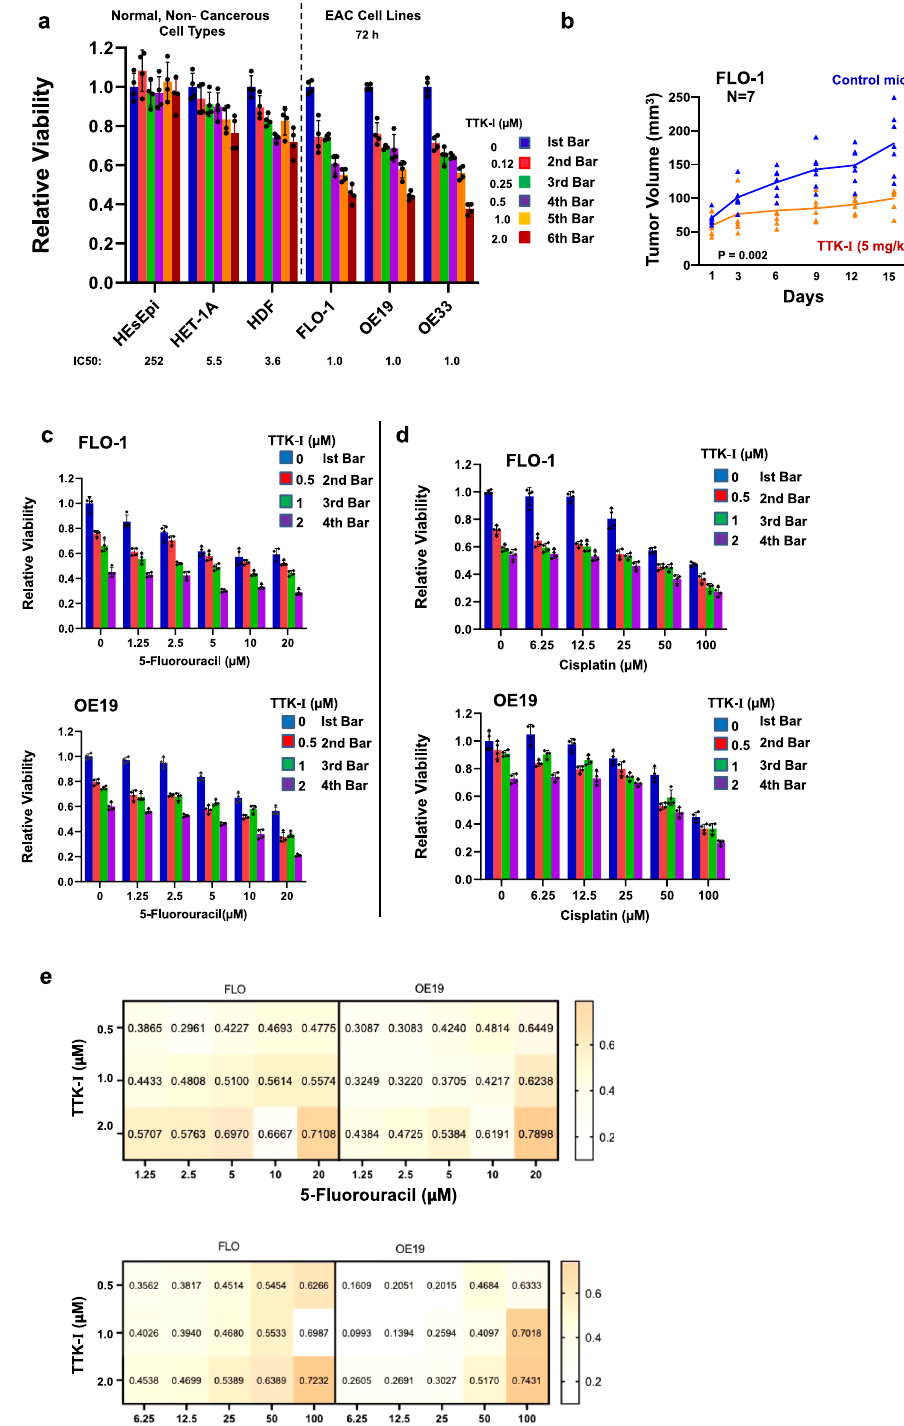
Fig. 6 A small-molecule inhibitor of TTK inhibits EAC cell growth in vitro and in vivo, and increases ef fi cacy of chemotherapeutic agents. a Normal or non-cancerous cell types (HEsEpi, primary human esophageal epithelial cells; Het-1A, SV40 large T-antigen-transfected human esophageal epithelial cells; HDF, human diploid fi broblasts) and EAC cell lines (FLO-1, OE19, AND OE33) were treated with TTK inhibitor (TTK-I, CFI402257) at various concentrations for 72 h and cell viability assessed. Error bars represent SDs of three experiments. b EAC (FLO-1) cells were injected subcutaneously in SCID mice and, following the appearance of palpable tumors, mice treated with TTK inhibitor. Tumor volumes were measured at indicated intervals. Error bars represent SDs of tumor sizes from nine control and nine treated mice. c – e EAC cell lines (FLO-1 and OE19) were treated with inhibitor (TTK-I, CFI402257), alone as well as in the presence of chemotherapeutic agents 5- fl uorouracil ( c ) or cisplatin ( d ), and cell viability measured after 72 h. Error bars represent SDs of three experiments. Panel e shows combination indexes (calculated using CalcuSyn software) of TTK-I with chemotherapeutic agents 5- fl uorouracil or cisplatin; a value <1 indicates a synergistic